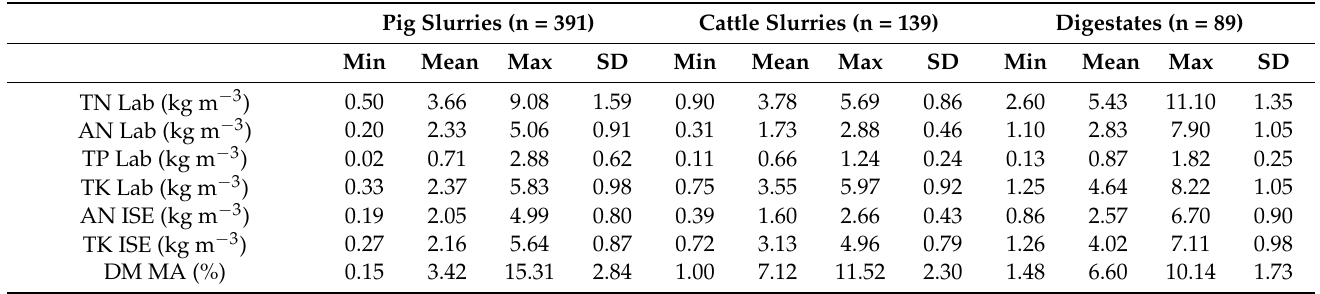
Table 1. Total nitrogen, ammonium nitrogen, total phosphorus, and total potassium concentrations in liquid organic manures based on laboratory measurements (Lab) and quick tests. Pig Slurries (n = 391) Cattle Slurries (n =